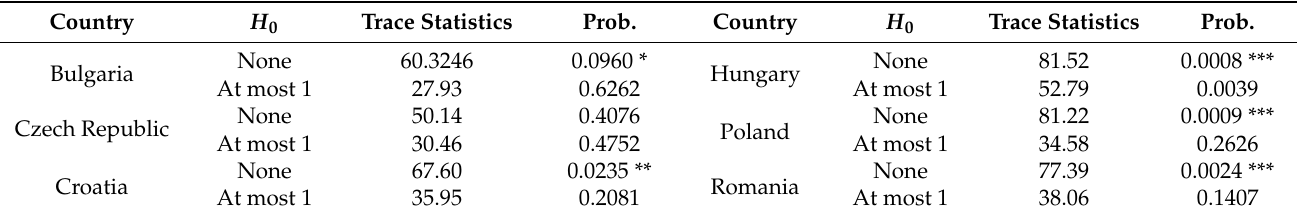
Table 4. Johansen’s cointegration tests.